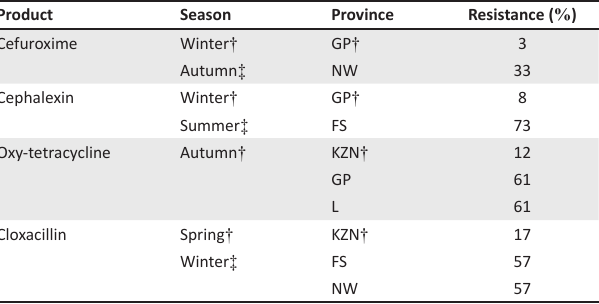
TABLE 4: Prediction of expectation of Staphylococcus aureus of antibiotic resistance to cefuroxime, cephalexin, oxy-tetracycline and cloxacillin for different seasons and provinces where significant differences were shown according to the analysis using the general linear mixed model. Product